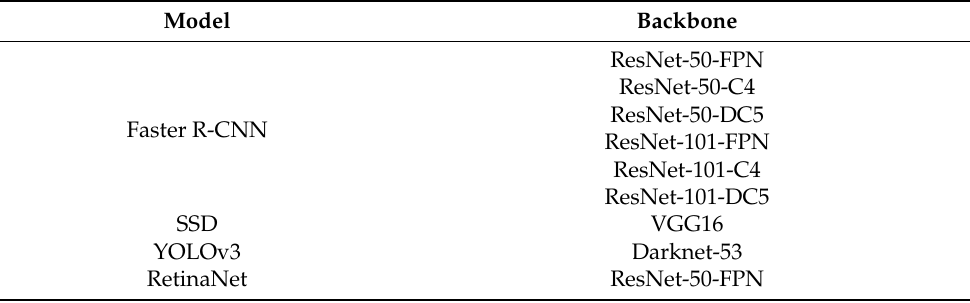
Table 1. State-of-the-art deep learning models used in this